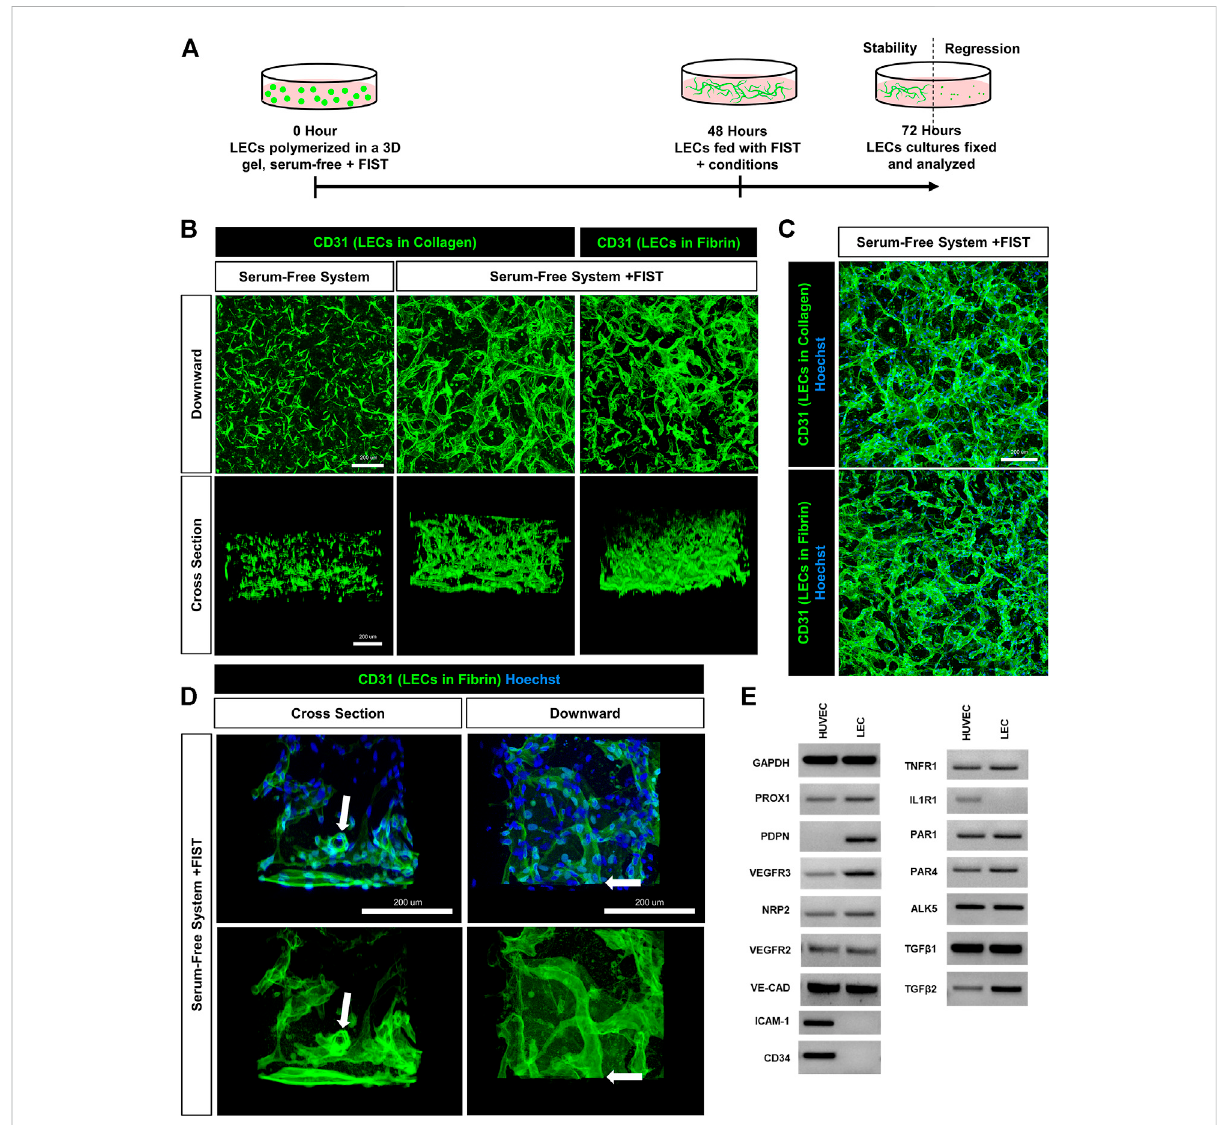
FIGURE 1 AhumanlymphaticECtubenetworkformationmodelsystemin3Dcollagenor fi brinmatricesunderserum-free,de fi nedmediaconditions. (A) Schematictimelinehighlightingtheimportanteventsintheassaymodels.Themodelutilizesaserum-free, fi vegrowthfactorsystem(IL[interleukin]- 3, SCF [stem cell factor, SDF [stromal cell-derived factor]-1 α , FGF [ fi broblast growth factor]-2, and insulin). In addition, a four-drug pharmacologic combination termed FIST (10 μ M forskolin, 100 μ M IBMX, 10 μ M SB239063, and 10 μ M Tubacin) was added to facilitate the formation of 3- dimensional (3D) lymphatic endothelial cell (LEC) tube networks. (B,C,D) LEC tube networks at 72 h. Fixed cultures were stained with anti-CD31 (green) and Hoechst (blue); imaged using confocal z-stack, 3D reconstructions. (B) Control LECs in serum-free, collagen gel, but no FIST (left column);LECs+FISTinserum-free,collagengel(middlecolumn);LECs+FISTinserum-free, fi bringel(right column); “ downward ” viewofconfocal z-stack reconstruction (top row); “ cross sectional ” view reconstruction (bottom row). (C) Additional imagesof LECs + FIST inserum-freemedia with nucleistaininginacollagengel(top)and fi bringel(bottom). (D) LECs+FISTinserum-freemedia. “ Crosssectional ” viewreconstruction(leftcolumn); “ Downward ” view reconstruction (right column). With nuclei staining (top row); without nuclei staining (bottom row). White arrows point to a lumenized tube that can be observed in cross-section. (E) HUVEC (EC) vs. dermal LECs (LEC) mRNA was isolated and RT-PCR analysis was performed. Expression of indicated genes was analyzed. GAPDH (glyceraldehyde-3-Phosphate Dehydrogenase), PROX1 (prospero homeobox 1), PDPN (podoplanin), VEGFR3 (vascular endothelial growth factor receptor 3), NRP2 (neuropilin 2), VEGFR2 (vascular endothelial growth factor receptor 2), VE-CAD (vascular endothelial cadherin), ICAM-1 (intercellular adhesion molecule 1), CD34 (hematopoietic progenitor cell antigen cluster of differentiation 34), TNFR1 (tumor necrosis factor receptor 1), IL1R1 (interleukin 1 receptor type 1), PAR1 and 4 (protease-activated receptor -1 and -4) ALK5 (activin-like kinase 5), TGF β 1 and 2 (transforming growth factor beta-1 and -2). Bars equals 200 μ